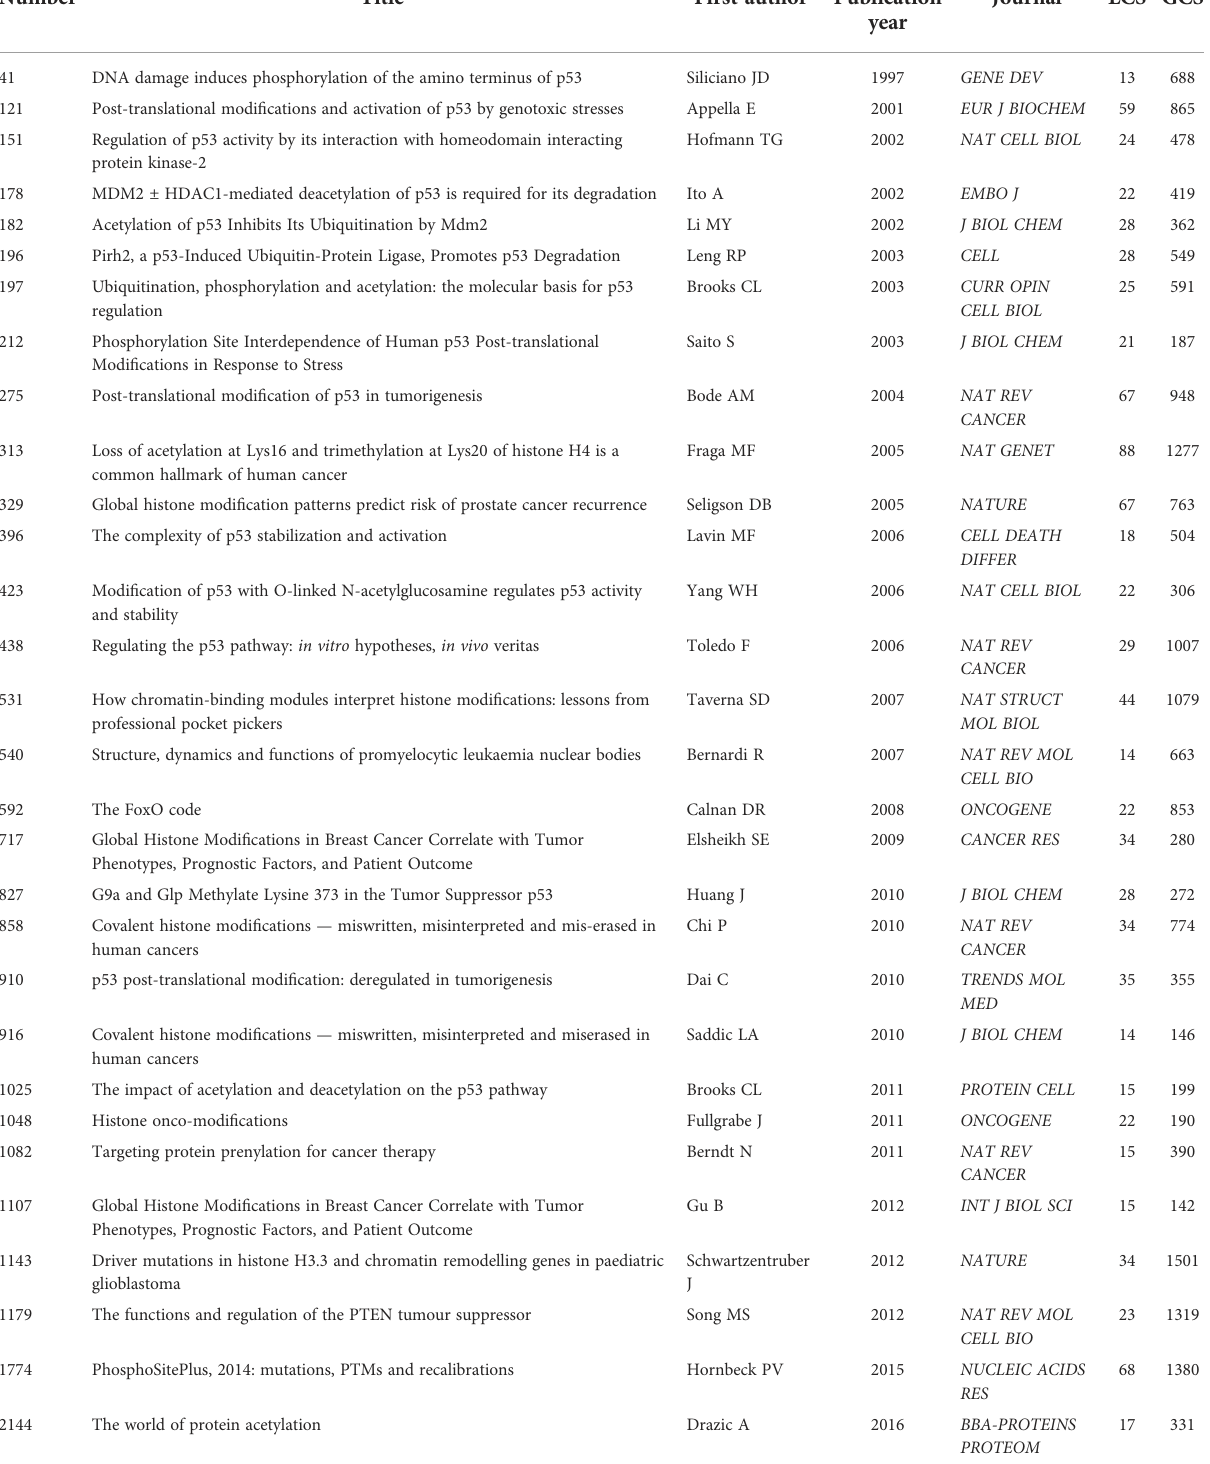
TABLE 3 The top 30 high-cited papers PTMs of cancer fi eld during 2011 to